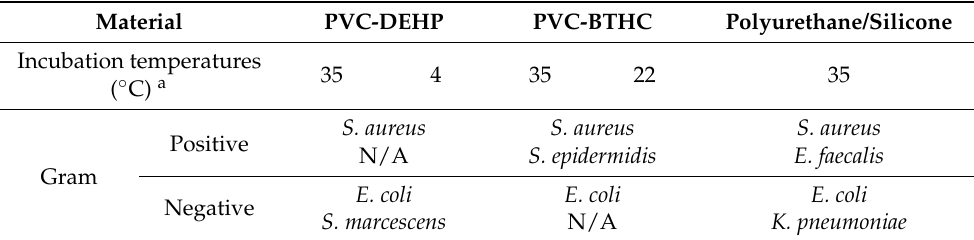
Table 1. Bacterial culture conditions for antibacterial activity